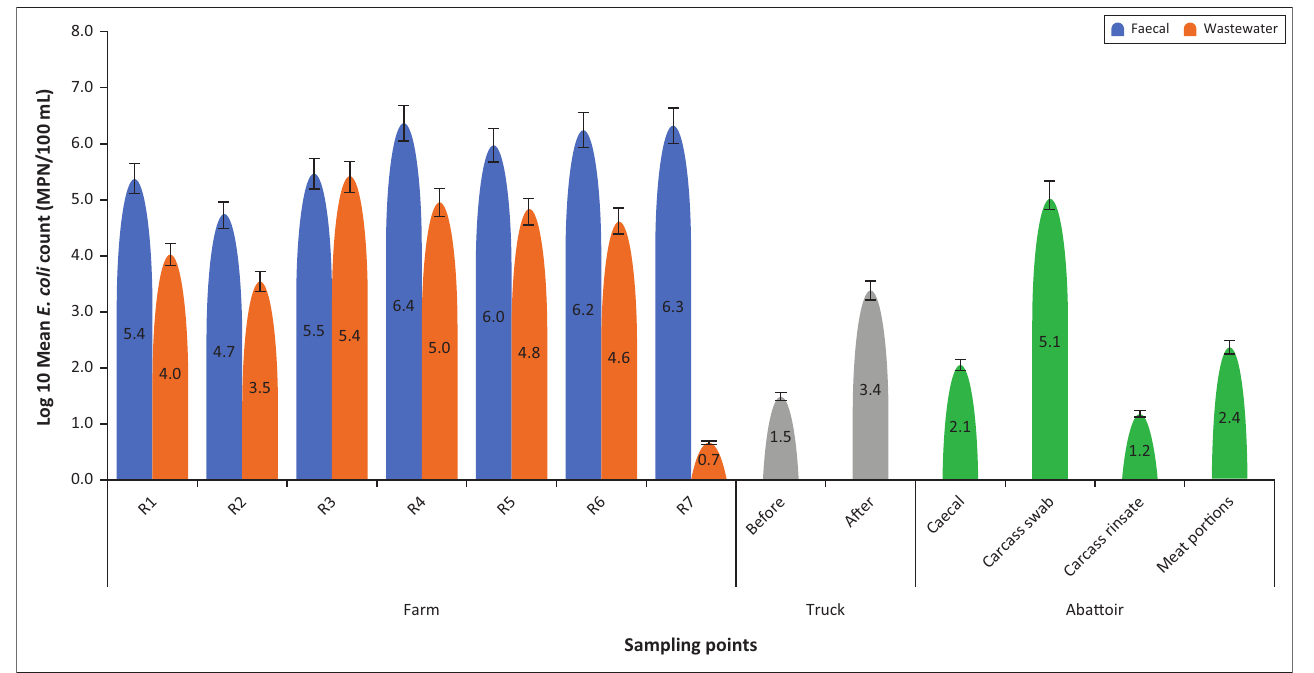
FIGURE 1: E. coli counts along the pig production continuum Farm (Round 1–7), Truck, Abattoir. Error bars represent 5 %